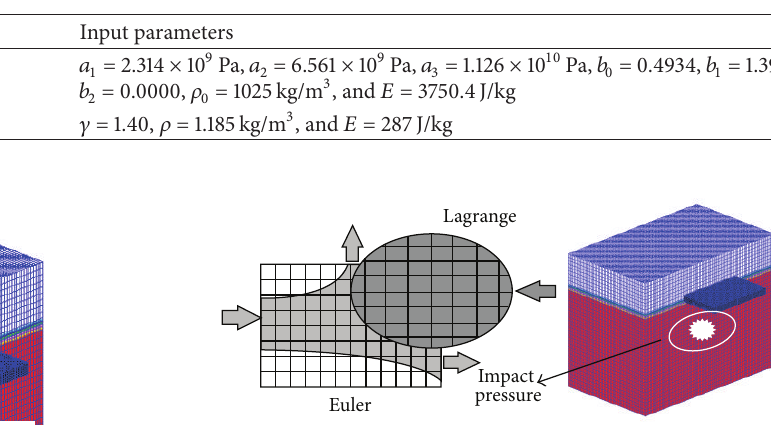
Table 2: Material properties (the fresh water and the air).